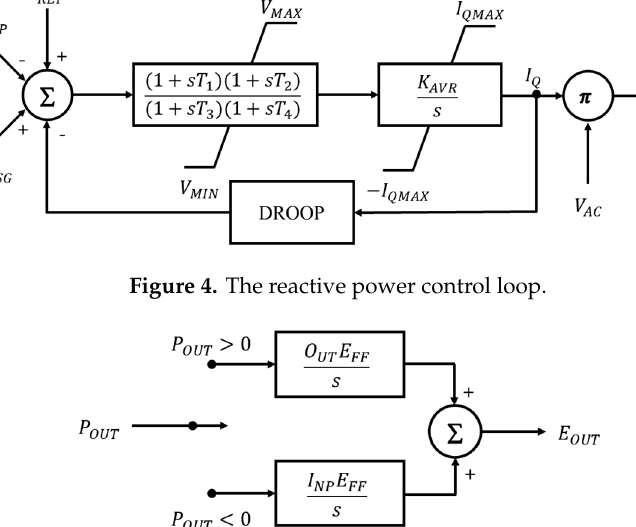
Figure 5. The charge and discharge mode.